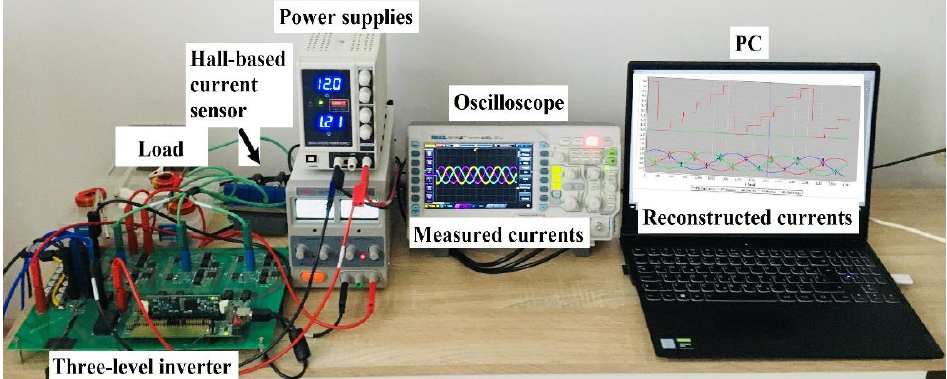
Figure 16. Measurement test-bench used for verification of the proposed SVM algorithm.